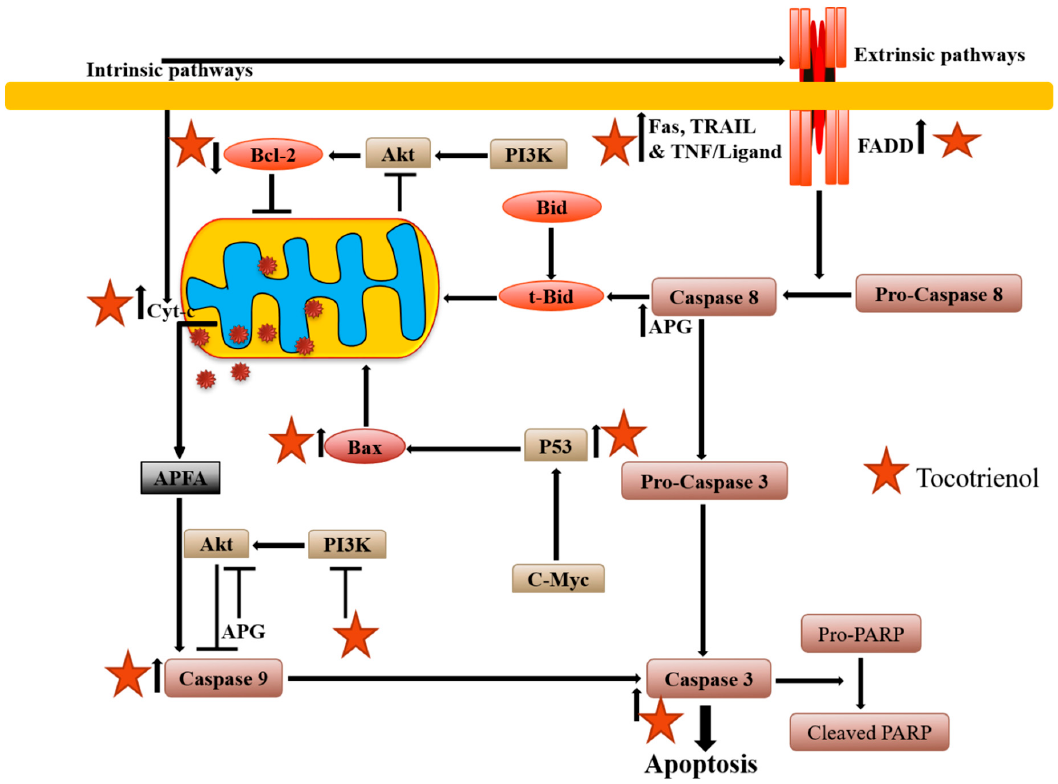
Figure 2. Diagrammatic representation of tocotrienols-mediated apoptosis activation. Tocotrienols can regulate both intrinsic and extrinsic apoptotic pathways via mitochondrial membrane potential depolarization, cyt. C (cytochrome complex) release, activation of caspase cascade and also modulation of Bcl-2 (B-cell lymphoma 2) as well as Bax expression.